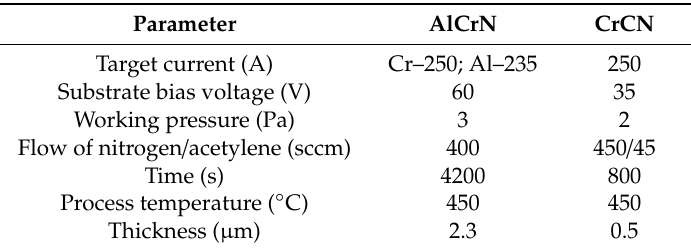
Table 1. Coating deposition